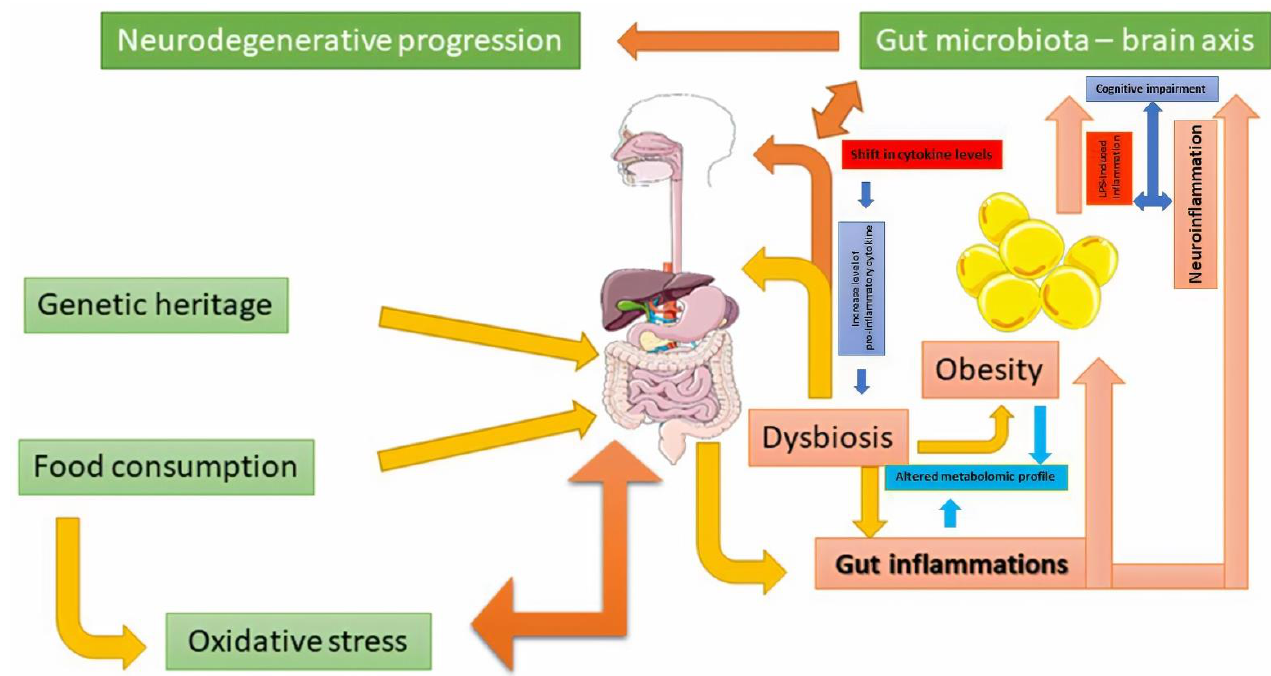
Figure 2. The relation between microbiota activity, obesity, and neuronal control. In this figure, food consumption and genetic heritage increased the pressure of oxidative stress at the colon level. This aspect may lead to dysbiosis and the proliferation of inflammations that induce obesity. This physiological degenerative health aspect may determine an imbalance in the gut-brain axis and develop neurodegenerative pathologies. This figure was obtained, in part, by using images from Servier Medical Art, licensed under CC-BY 3.0, and the PowerPoint program from the Microsoft Office 2016 software package (Microsoft Corporation, Redmond, WA, USA).